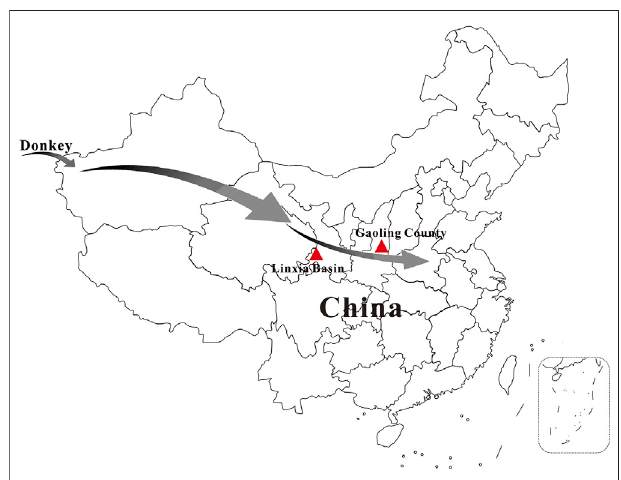
FIGURE 1 | Sampling locations of Chinese ancient donkeys analyzed in this study. Sample LXH1 was excavated from Linxia Basin, specimens SG1 and SG3 were collected from Gaoling County. The arrows indicate possible dispersal route of domestic donkey to ancient